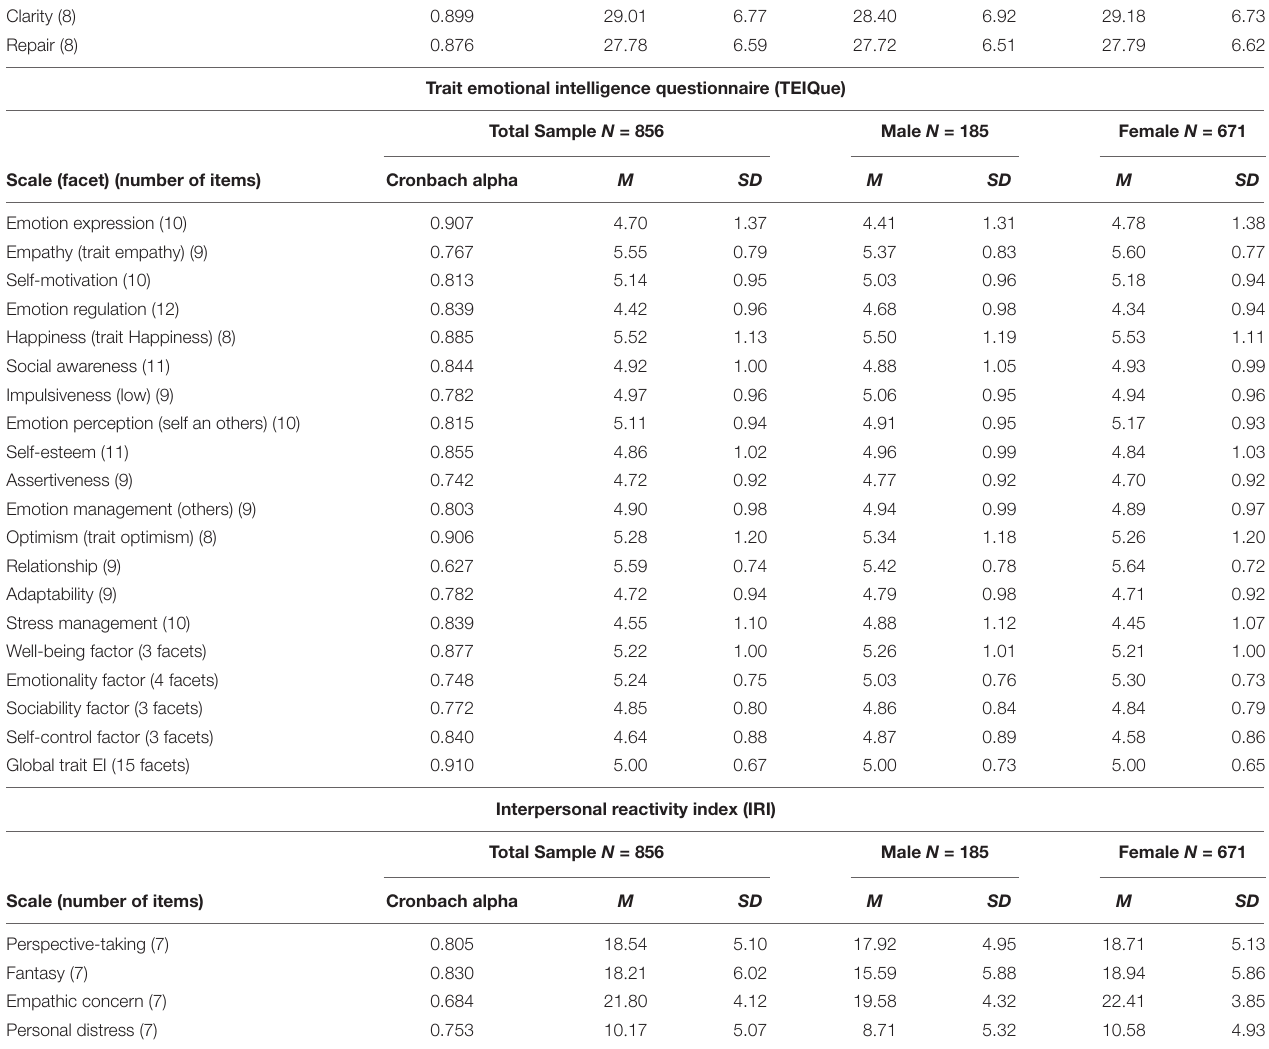
Trait meta-mood scale